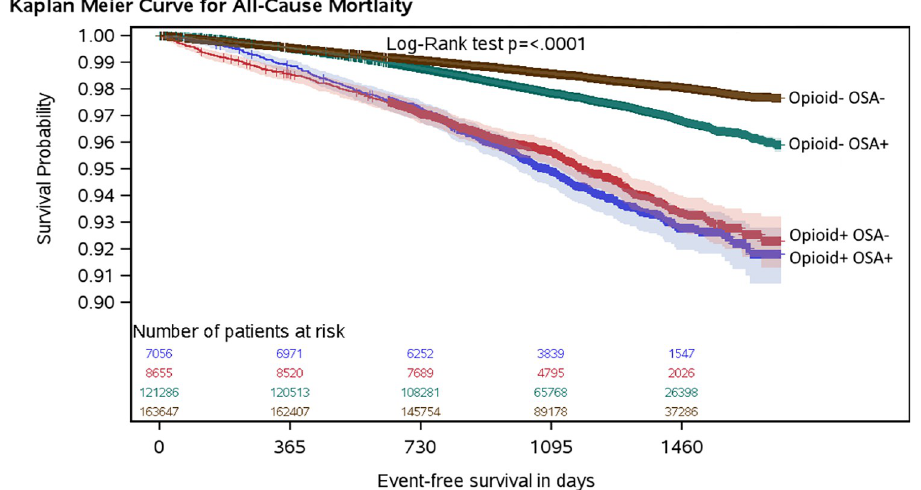
Fig 1. Unadjusted Kaplan-Meier survival curves by exposures of interest: at least a 50% probability of moderate to severe obstructive sleep apnea (OSA+) and active opioid use (Opioid +). The numbers at risk are presented above the x-axis: from top to bottom, Opioid+ OSA+; Opioid+ OSA-; Opioid- OSA+; Opioid-